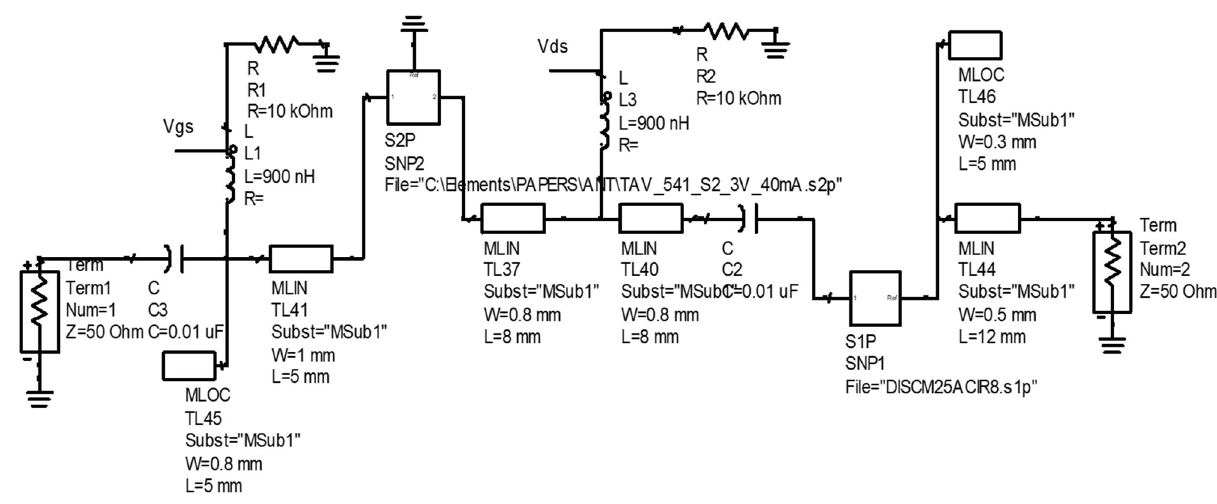
Figure 11. Matching network of the circular polarized active receiving sensor.